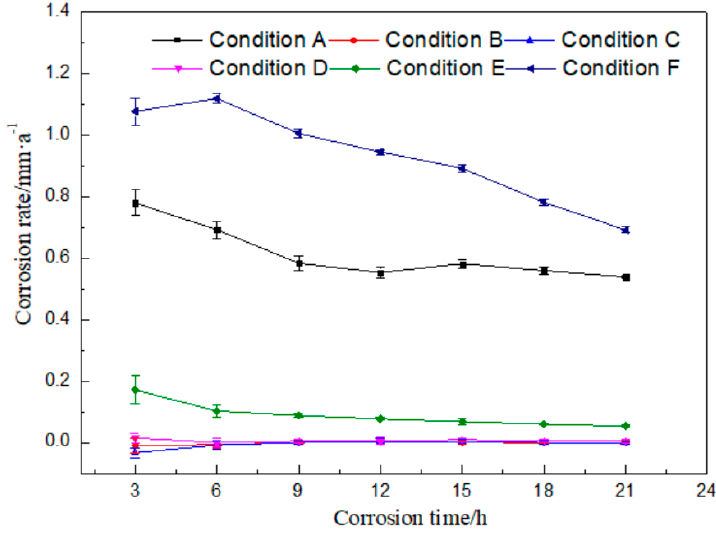
Figure 2. Corrosion rates of the rolled copper foil in different conditions against corrosion time.